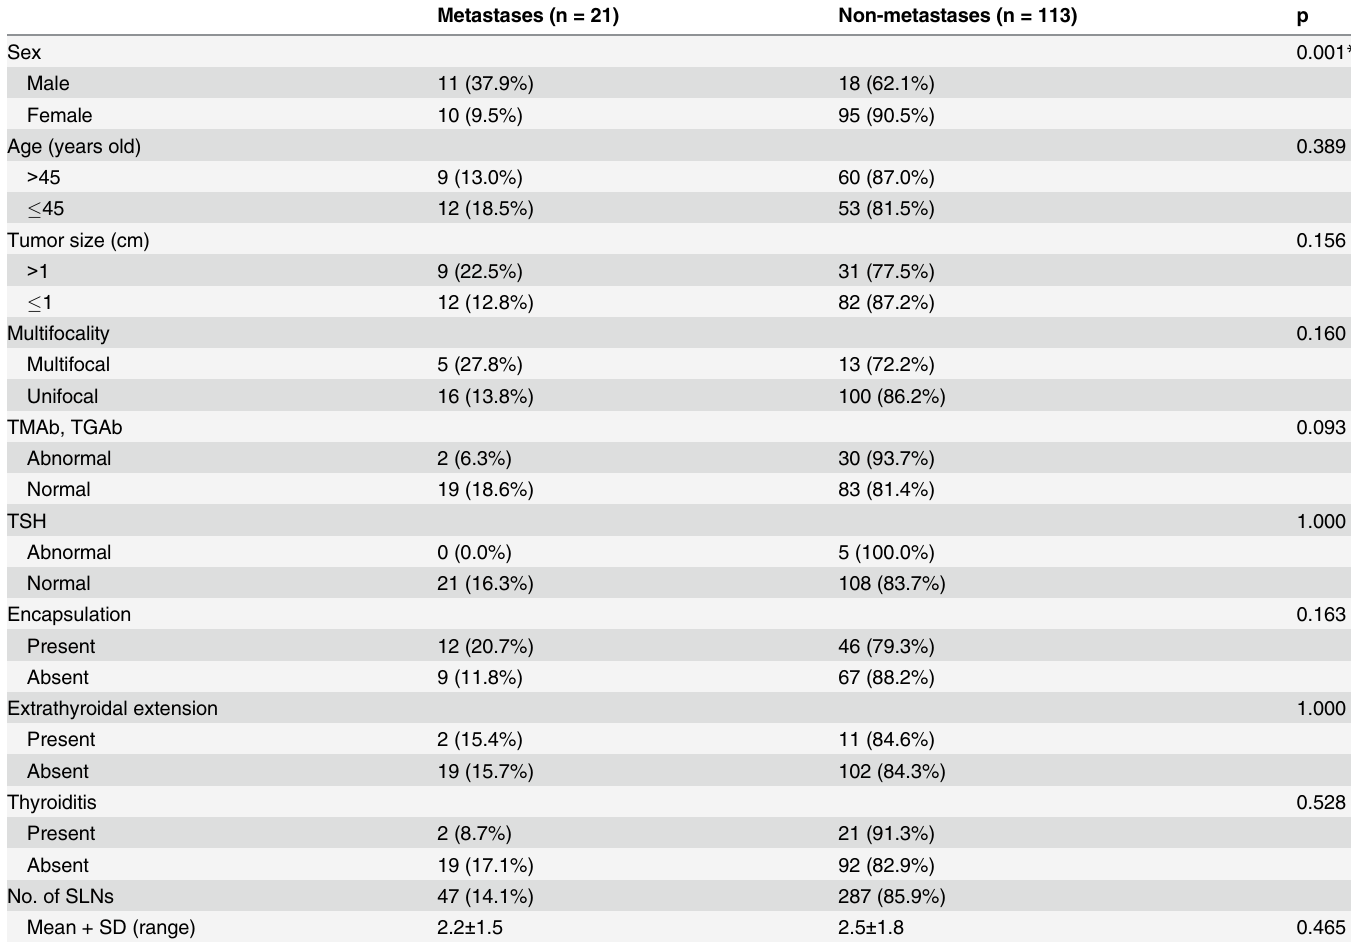
Table 5. Comparison of SLN-negative patients with and without non-SLN metastasis (n =